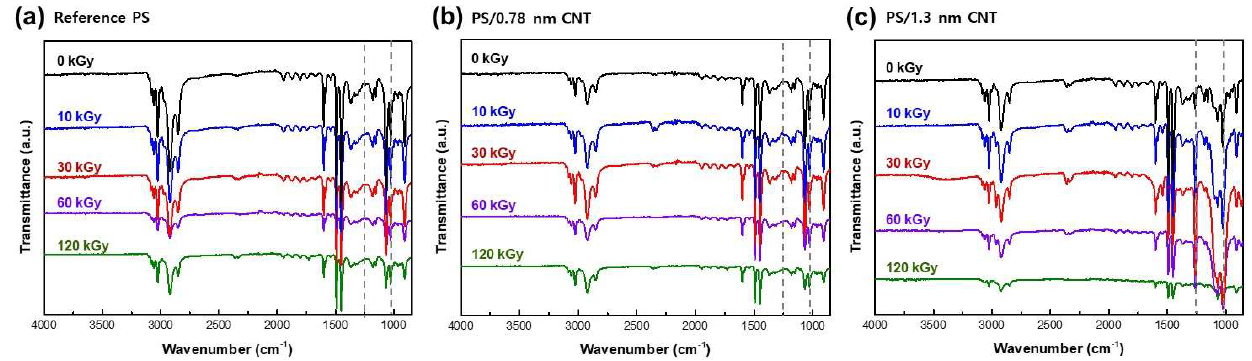
Figure 5. Fourier-transform infrared spectroscopy spectra for PS ( a ), and PS/SW-CNT composites with an SW-CNT diameter (0.78 nm ( b ) and 1.3 nm ( c )) upon gamma irradiation.